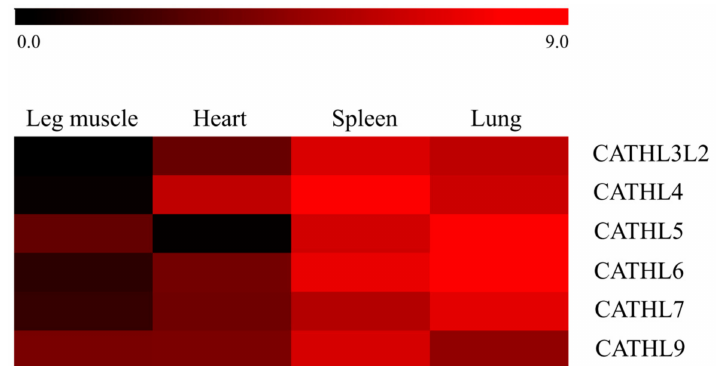
Figure 5. Relative expression levels of functional cathelicidin (CATHL) genes in forest musk deer. The expression levels of the forest musk deer cathelicidins were calculated relative to that of CATHL3L2 using glyceraldehyde-3-phosphate dehydrogenase (GAPDH) as a reference gene. The color elements represent average log 2 ratios of fold change from three